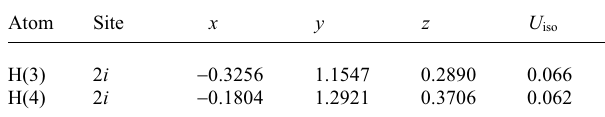
Table 3. Atomic coordinates and displacement parameters (in Å 2 )